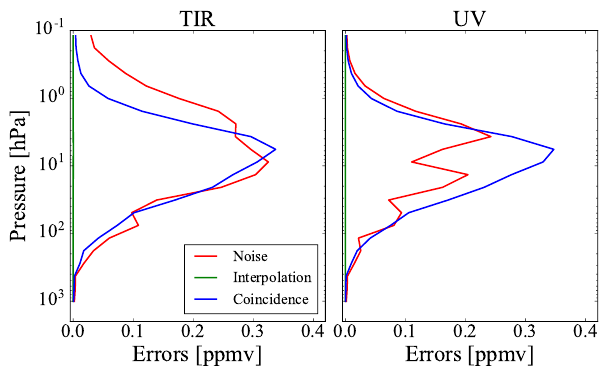
Figure 5. As Fig. 4 but for case 3.